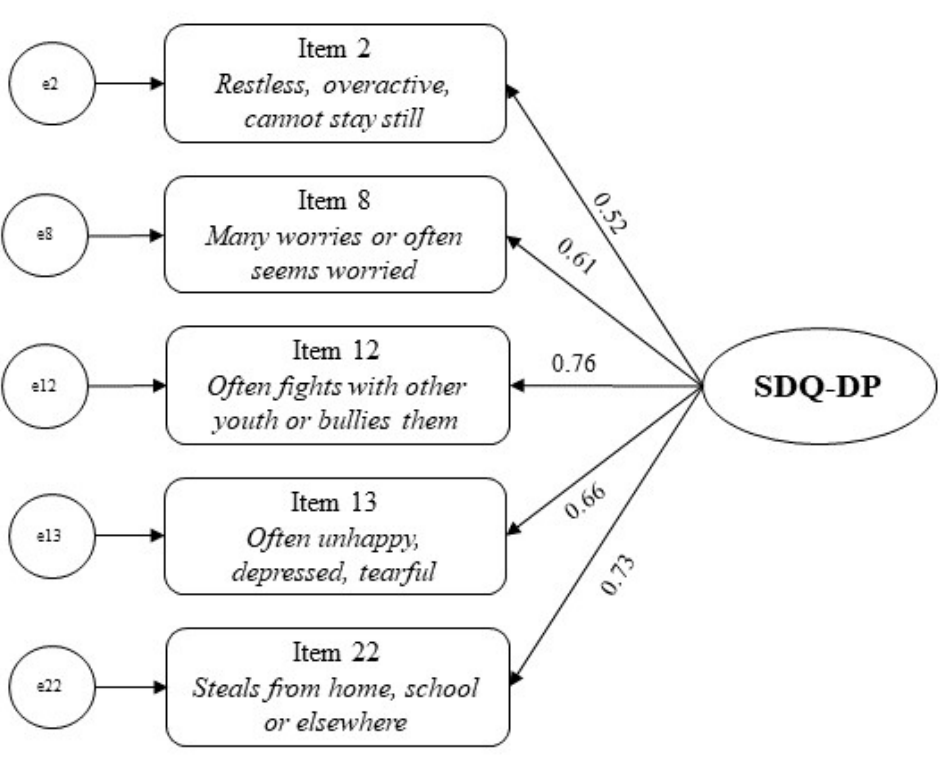
Figure 1. Factor loadings for the SDQ-DP